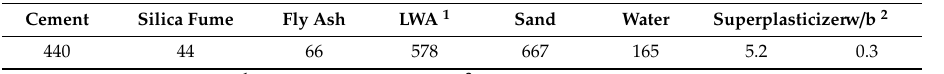
Table 2. Mix composition of plain LWAC / (kg / m 3 ).